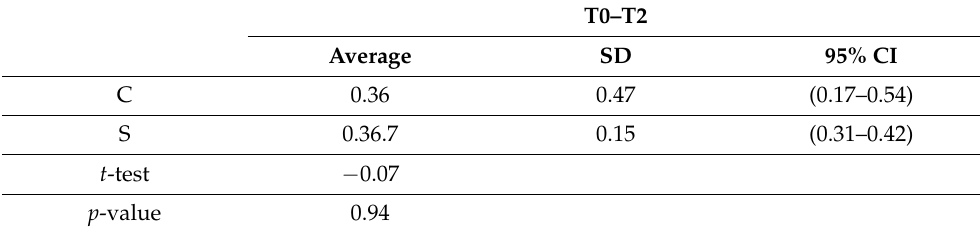
Table 5. Bone loss in crestal and subcrestal implants.